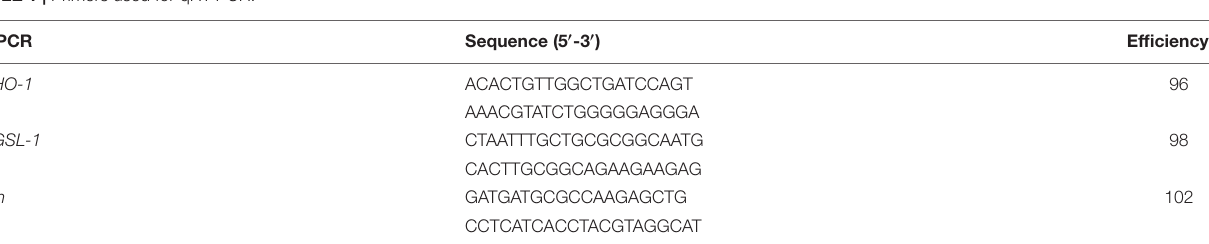
FIGURE 8 | Histone acetylation induced chromatin accessibility of the promoter region in ZmHO-1 and ZmGSL-1 . (A,B) CHART-PCR assay was performed with nuclei digested by MNase to measure chromatin accessibility of the specific promoter region of ZmHO-1 and ZmGSL-1 . The PCR products was converted from the Ct values according to the standard curve. All experiments were repeated three times. Asterisk ( ∗ ) indicated that the relative PCR product in ZmHO-1 and ZmGSL-1 of the TSA treatment group was significantly different from that of the control group ( t -test, p < 0.01). TABLE 1 | Primers used for